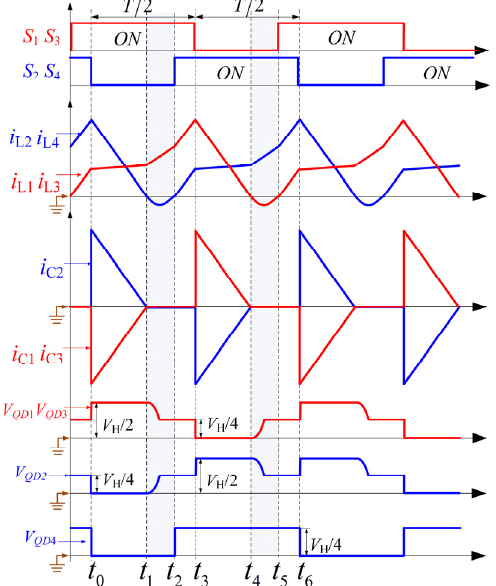
Figure 12. Operating waveforms for the DCM Boost